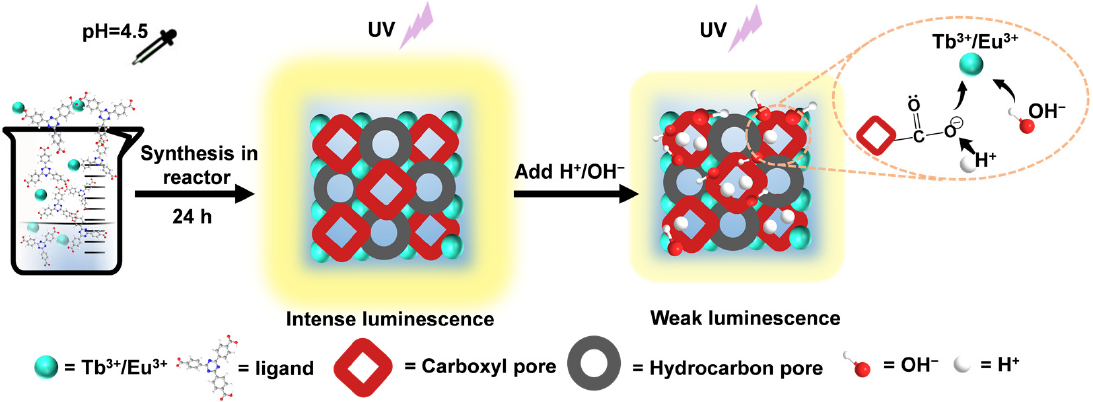
Figure 1. Preparation of Ln-TATB and schematic diagram of framework luminescence change behavior caused by strong acid–base environment.